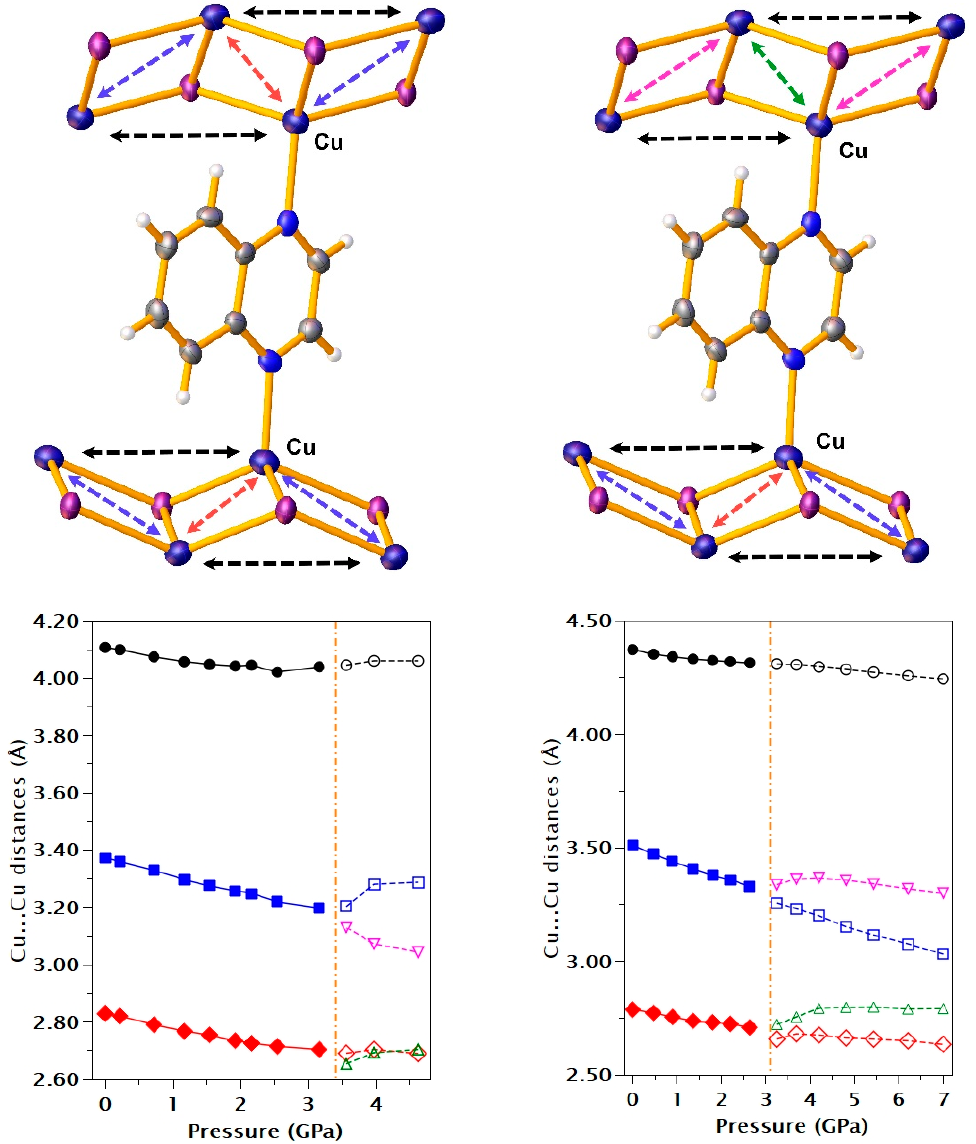
Figure 4. Variation in Cu–Cu distances with pressure for [(CuX) 2 (Quin)] (X = Br, I). Upper plots correspond with the scheme of distance variation before and after the phase transition: monoclinic ( left ) and triclinic ( right ). Different colored arrows correspond to different Cu–Cu interactions. The bottom part of the figure shows the Cu–Cu distances for [(CuBr) 2 (Quin)] ( left ) and for [(CuI) 2 (Quin)] ( right ) as a function of pressure. Error bars are smaller than respective symbols. Colored lines correspond with the different Cu–Cu interactions shown in the upper part of the figure.